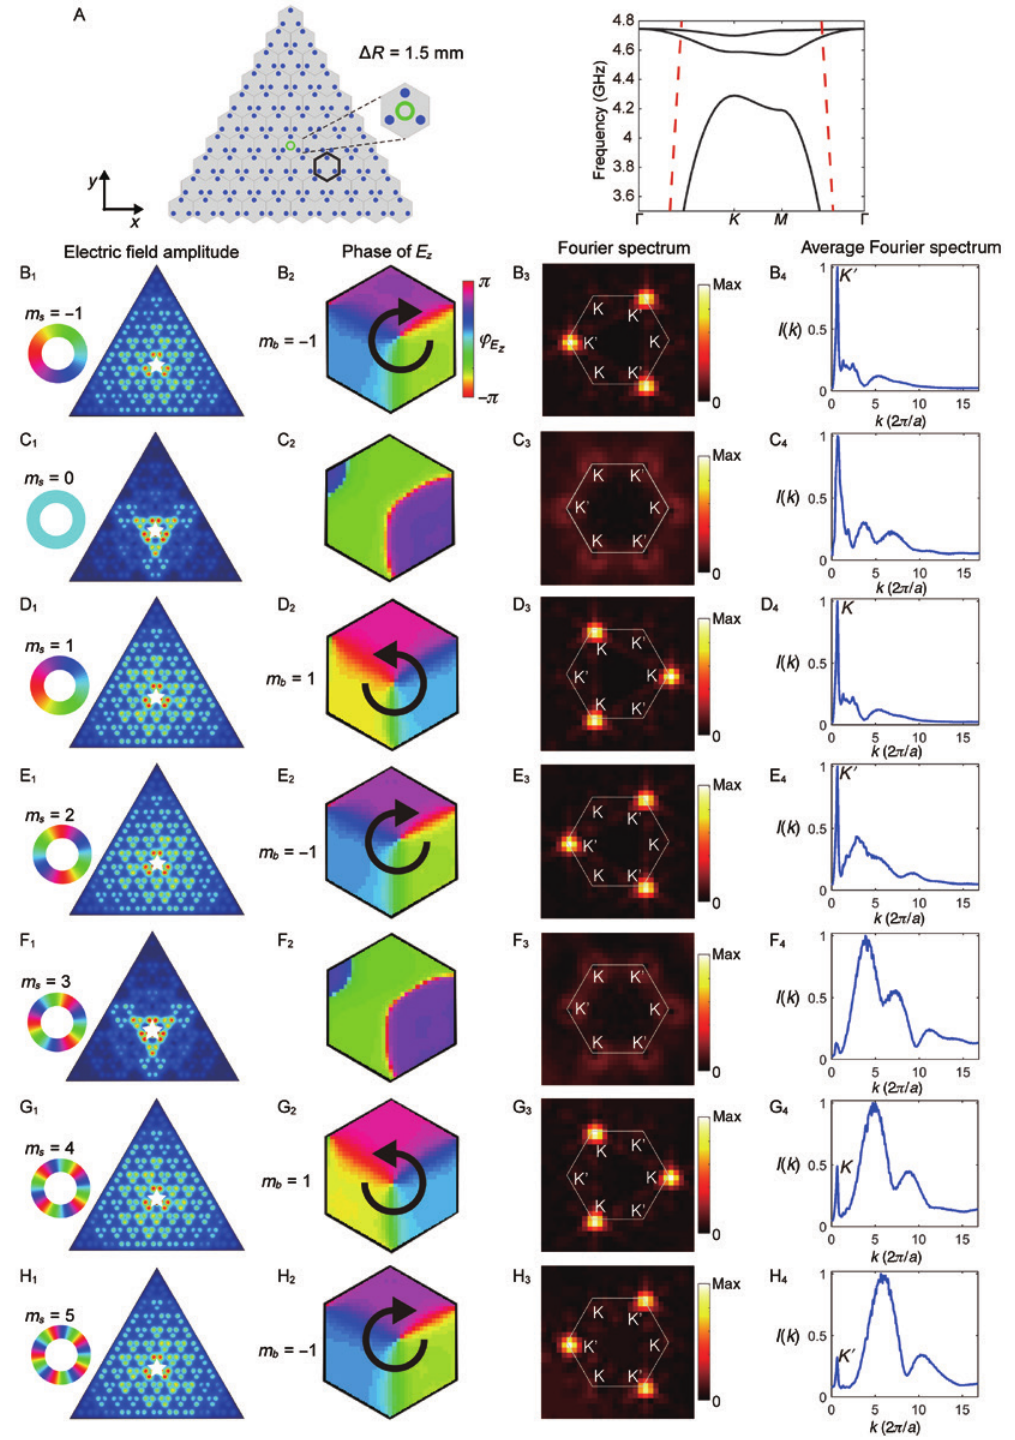
Figure 2: Excitation of valley bulk states by sources with higher-order vortex index at the frequency of 4.28 GHz. (A) Left: top view of the Kagome PC with Δ R = 1.5 mm. The green circle in the inset denotes the source. Right: bulk band structure of the Kagome PC shown in the left. (B ) Electric field distribution of the valley bulk states excited by the source with m 1 magnitude of the source is constant. The white star at the center denotes the source and the left inset shows the phase pattern of source. (B ) Phase of E in B in the unit cell highlighted by the bold black hexagon in A. The black arrow indicates the direction of phase gradient. 2 z 1 (B ) Spatial Fourier spectrum of the E component in B . The gray solid hexagon denotes the first Brillouin zone of the PC. (B 3 z 1 of the averaged Fourier spectrum I ( k ) along the radial direction in momentum space. (C–H) Same as in B but for the sources with m from 0 to 5. Here, m and m represent the vortex index of the source and the valley bulk state, s b